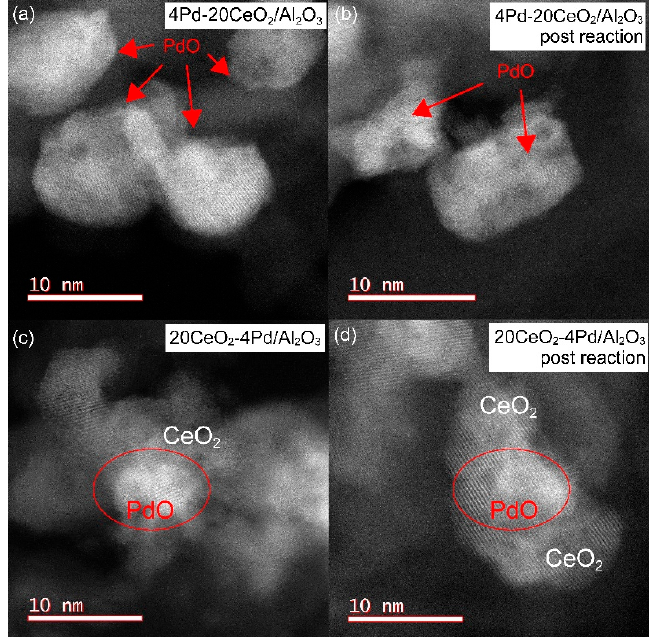
(black background) after reaction; ( c ) PdO particles are embedded on ceria before reaction; ( d ) PdO particles are embedded on ceria after reaction.